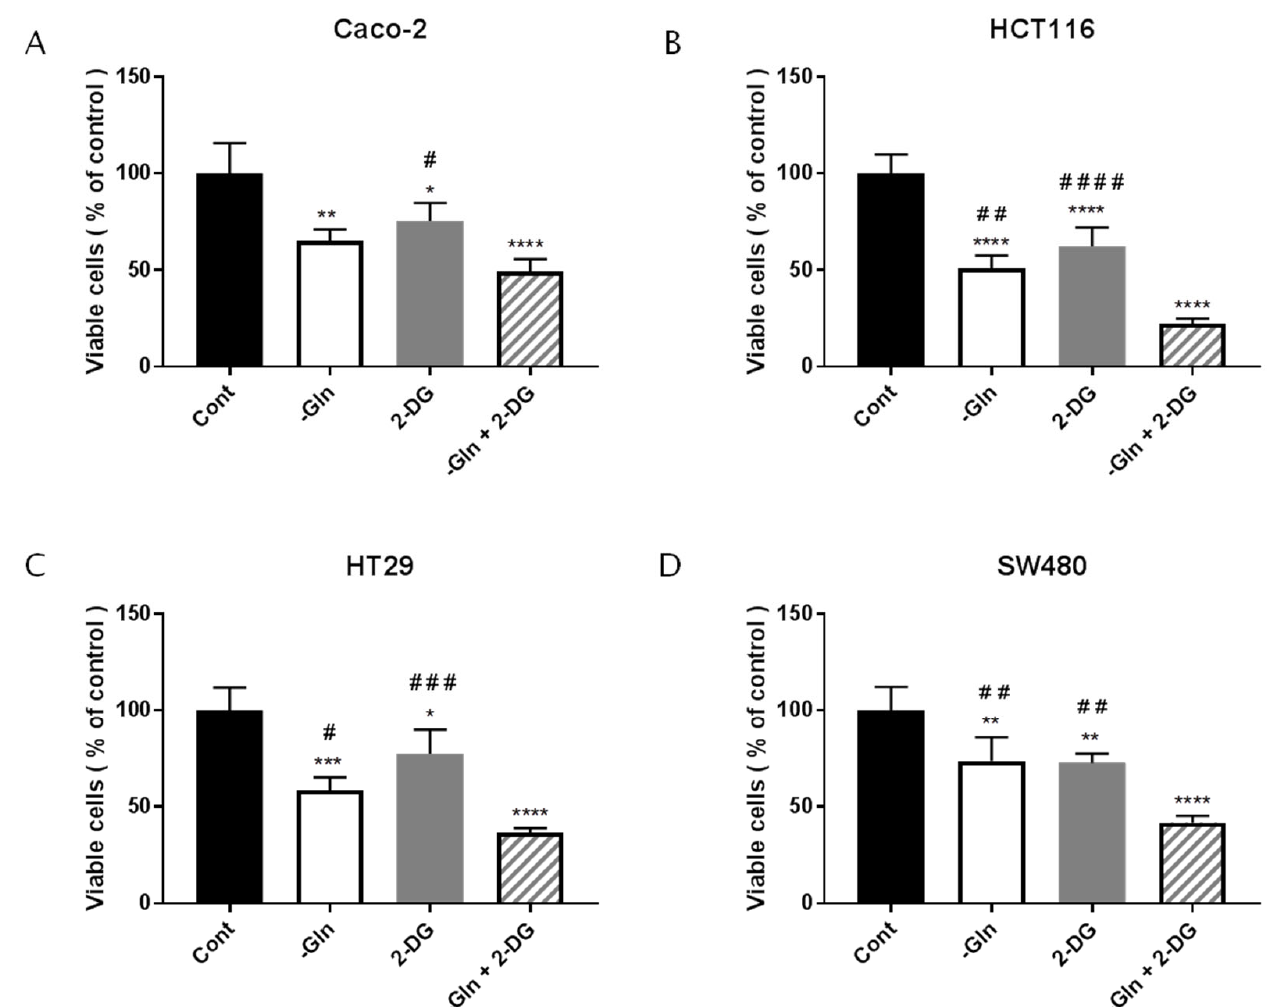
Figure 7. Combined treatment with glutamine deprivation and 2 ‐ DG induced stronger cytotoxic effects in colorectal cancer cells (( A ) Caco ‐ 2, ( B ) HCT116, ( C ) HT29, ( D ) SW480). Cells were treated with 2 ‐ DG (2.5 mM Caco ‐ 2, HCT116 and HT29, 5 mM SW480 cells) in the presence or absence of Gln (Cont) for 48h. Viable cells were evaluated with MTT assay. Data are presented as mean ± SD ( n = 3, * p < 0.05, ** p < 0.005, *** p < 0.0005, **** p < 0.0001 compared with Cont; # p < 0.05, ## p < 0.005, ### p < 0.0005, #### p < 0.0001 compared with combined treatment). One ‐ way ANOVA statistical analysis was performed.